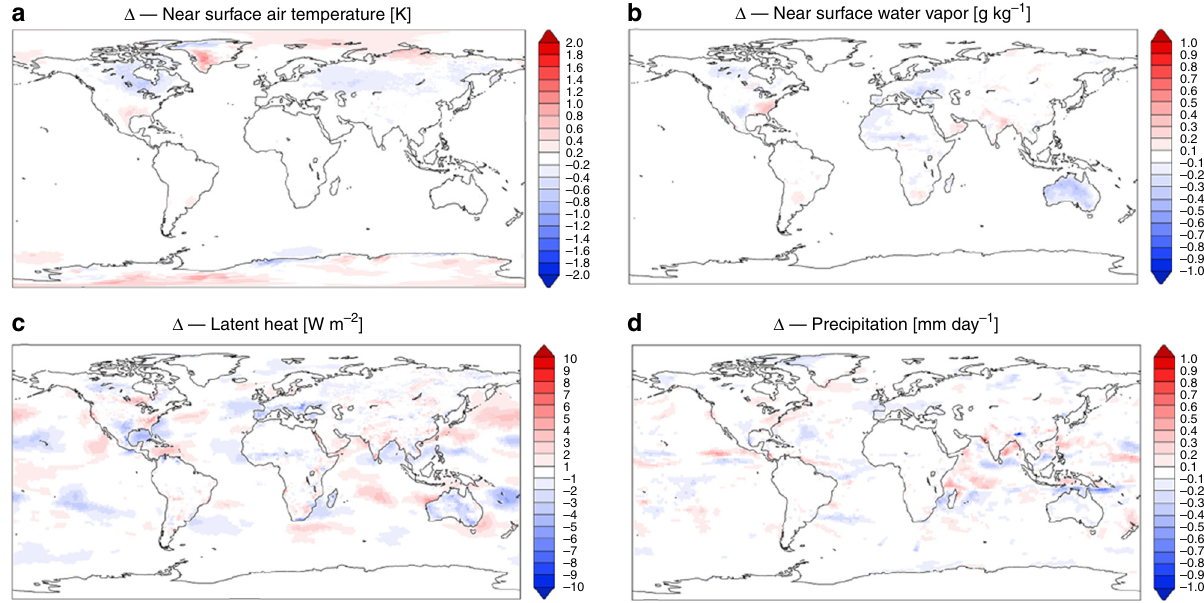
Fig. 5 Global-scale effects on climatic variables. Differences in ( a ) near-surface air temperature [K], ( b ) near-surface water vapor [g kg − 1 ], ( c ) latent heat fl ux [W m − 2 ], and ( d ) precipitation [mm day − 1 ] averaged over 30 years of simulations with soil structure (WSS) compared with no soil structure (NSS), i.e., Δ = WSS − NSS, using the global climate model